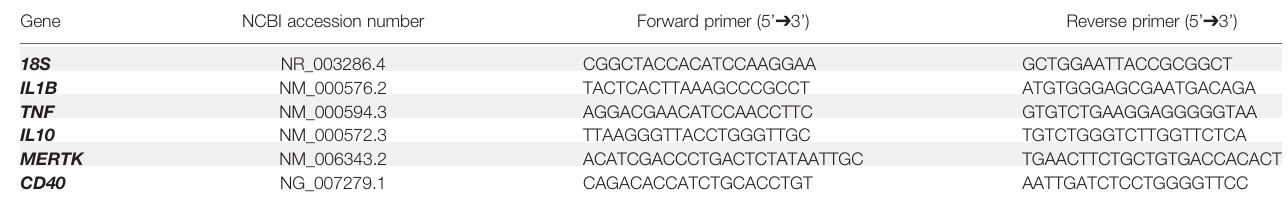
TABLE 2 | List of primer pairs used for qPCR reactions.